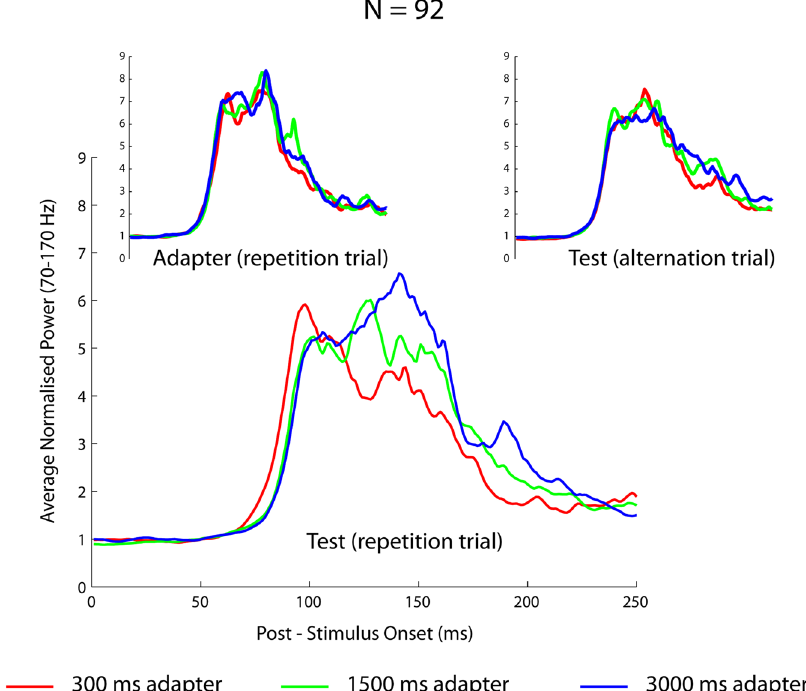
Figure 7. Gamma power (70–170 Hz) to adapter and test stimuli as a function of adapter duration. Averaged normalized gamma power during the first 250 ms of stimulus presentation for the test stimuli following a 300, 1500 and 3000 ms adapter in repetition trials. Insets shows averaged normalized power for the adapter in the same repetition trials (left inset) and test stimuli in alternation trials for the 3 different adapter duration conditions. The LFPs were obtained simultaneously with the single units of Figs 2 and